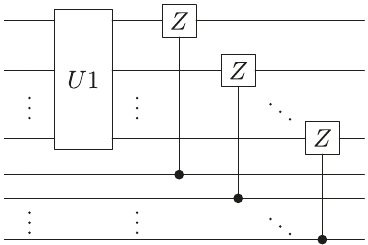
Fig. 2 The 2 n -qubit circuit U 0 . This circuit contains the n -qubit 1 circuit U 1